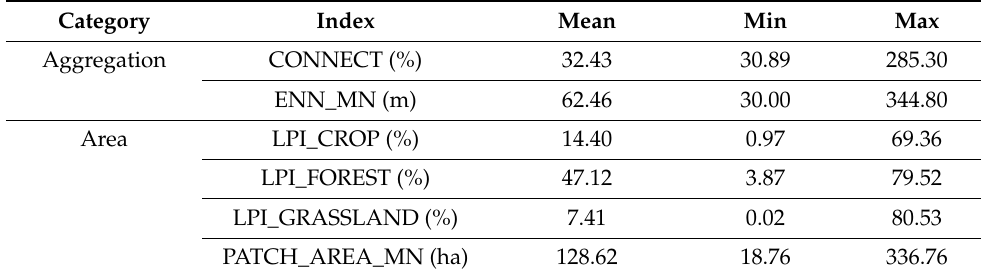
Table 2. Summary of the landscape indices (described in Table 1; acronyms correspond to standard FRAGSTATS metrics) obtained for the 26 landscapes analyzed. We present mean, minimum, and maximum values. MN = average area